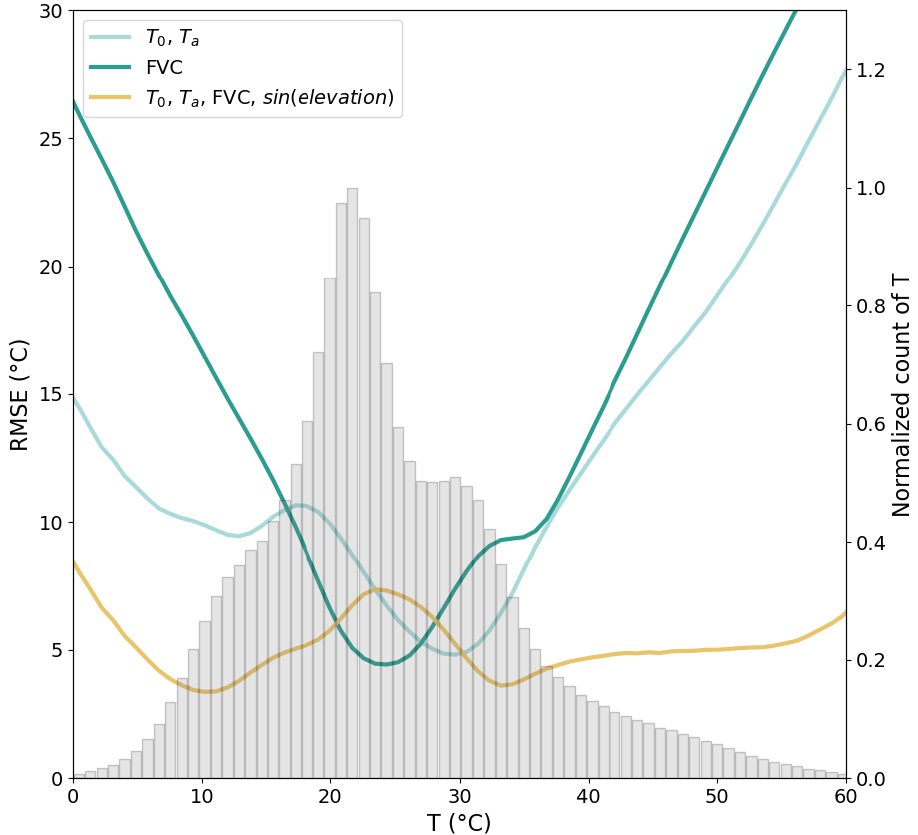
Figure 3. Root Mean Square Deviation (RMSD) of the T estimated with the statistical function F as a function of T , for different combinations of the predicting ancillary variables. In blue F is trained with T 0 and T a , with only FVC in green, and finally with T 0 , T a , FVC , and sin ( α S ) in brown. The distribution of T in the testing set is shown in gray bars (labels on the right